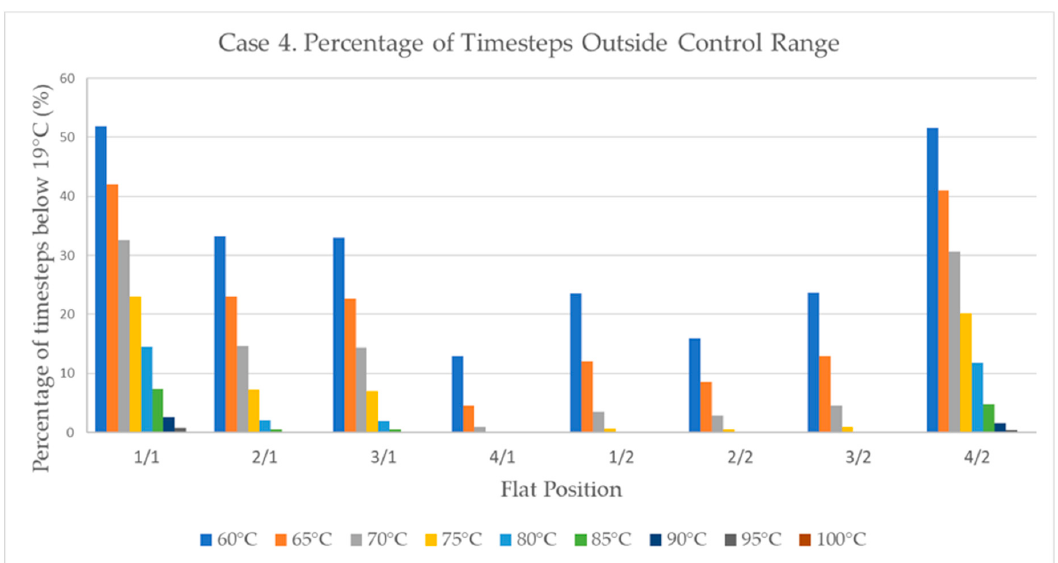
Figure 12. Case 4: insulation and double glazing.